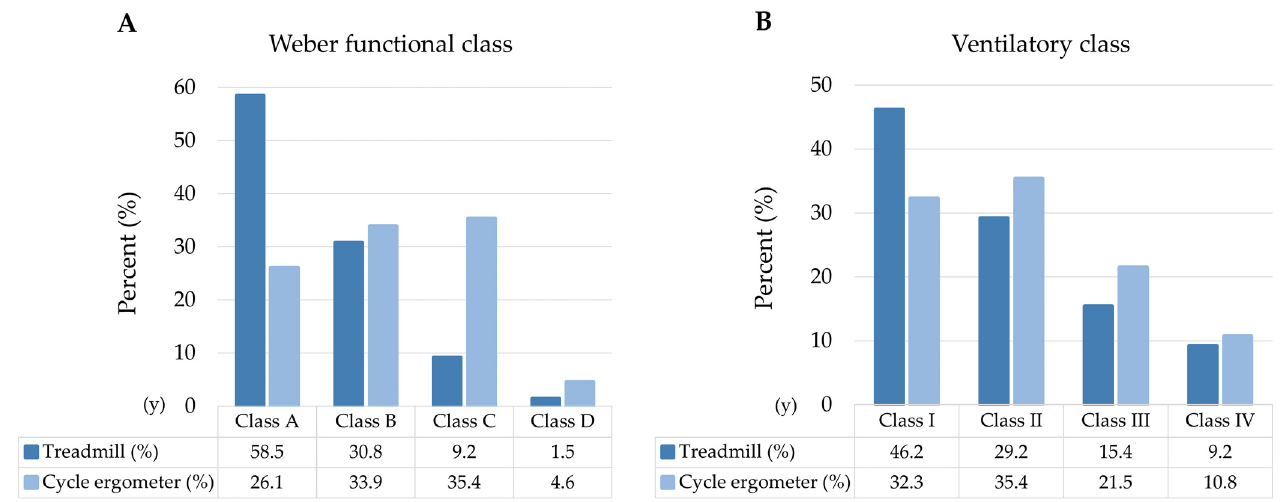
Figure 4. ( A ) Analysis of the Weber functional class as a function of peak VO 2 /kg and ergometer. ( B ) Ventilatory class according to VE/VCO 2 slope and ergometer.